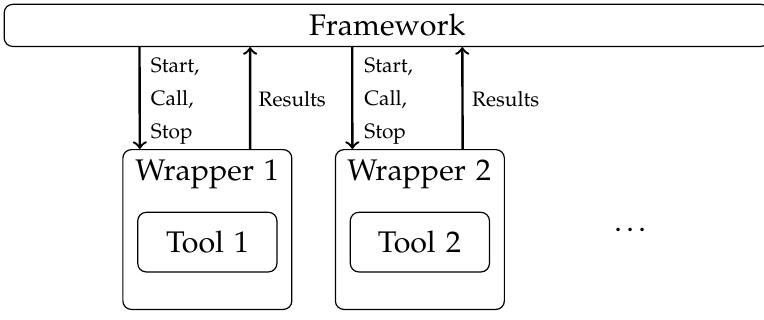
Figure 7. Framework interaction with integrated